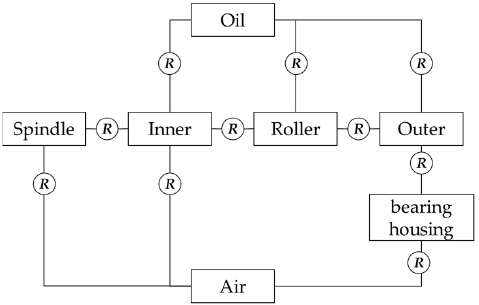
Figure 3. Relation diagram of heat transfer between the parts in bearing.